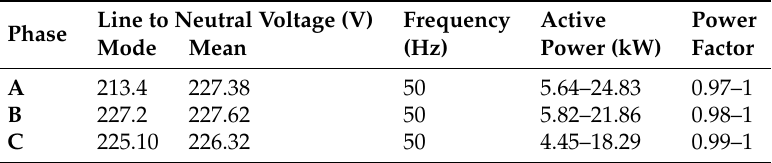
Table 11. Grid parameters: office